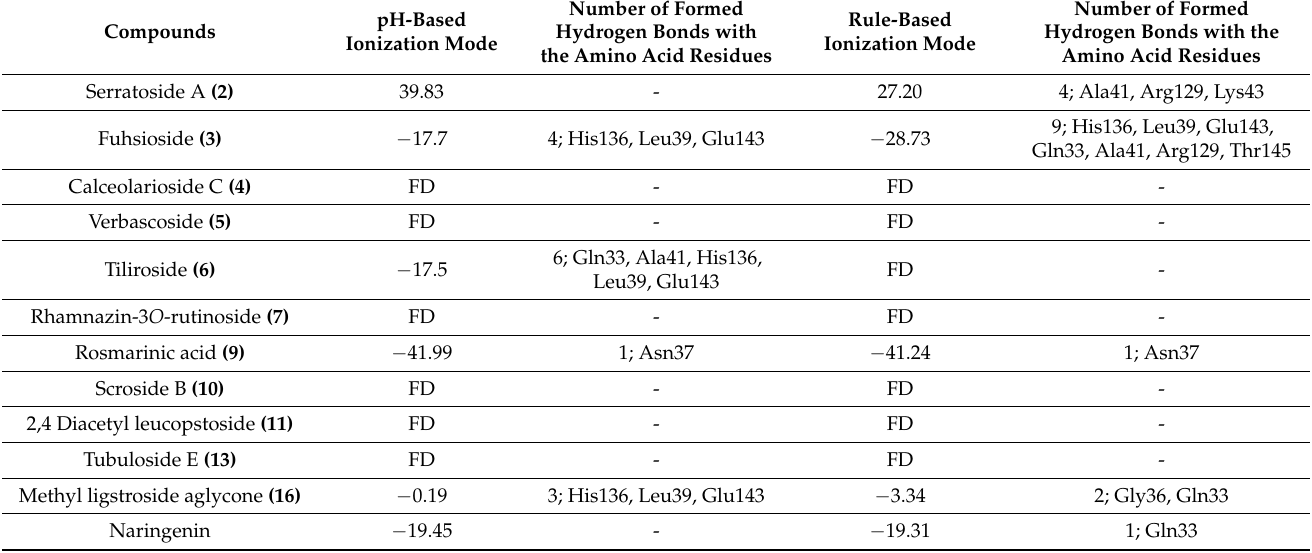
Table 3. Binding energies (kcal/mole) of major identified phytoconstituents present in the total methanol extract of C. speciosum leaves within the active sites of daf-2 protein employing both pH-based and rule-based ionization